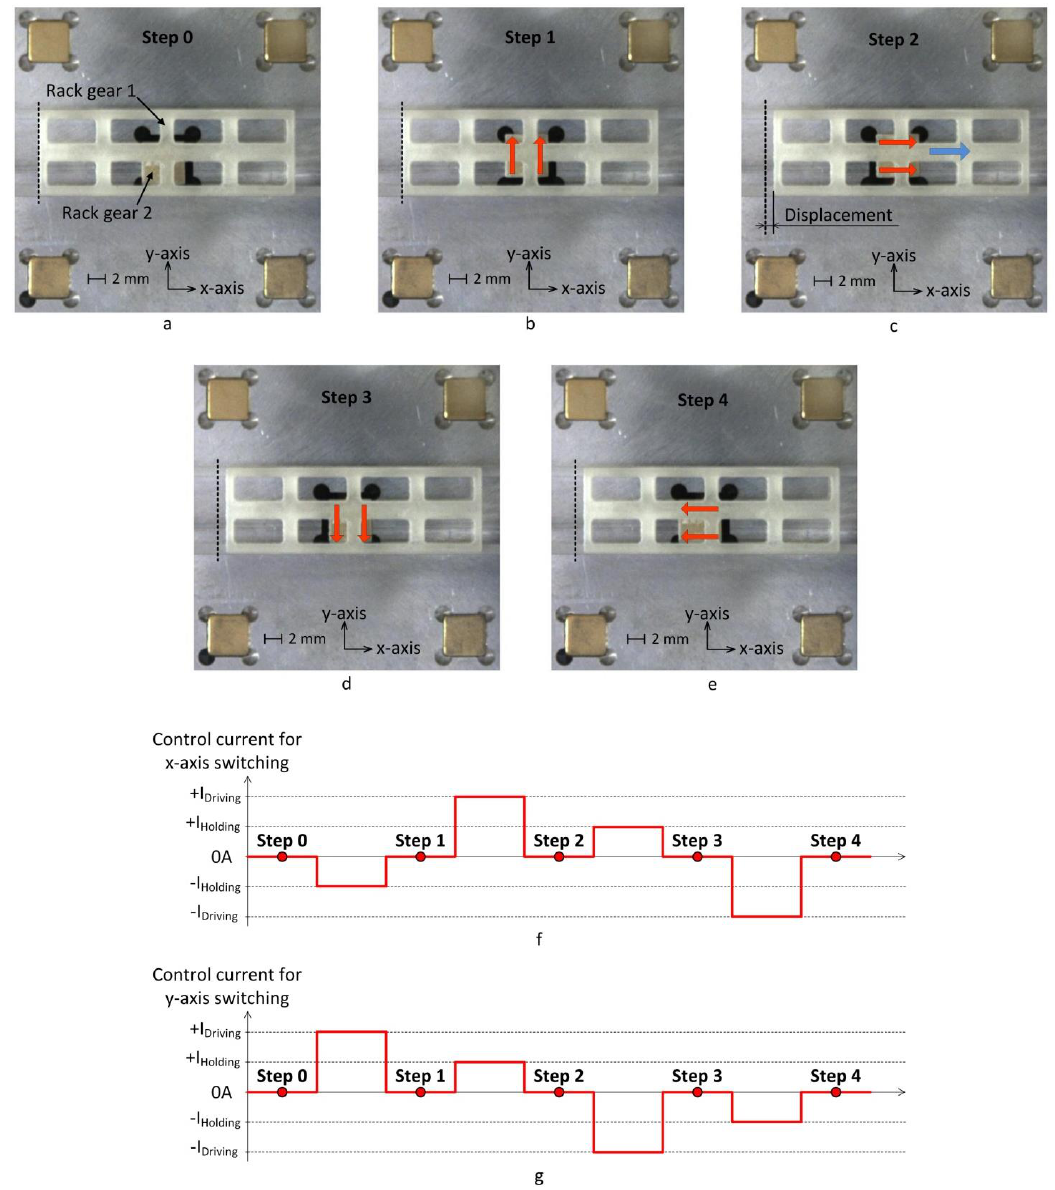
Figure 11. Displacement sequence of the linear conveyor: ( a , b , c , d , and e ) pictures of the prototype during the displacement sequence, ( f ) control signal for x -axis switching used for the sequence, ( g ) control signal for y -axis switching used for the